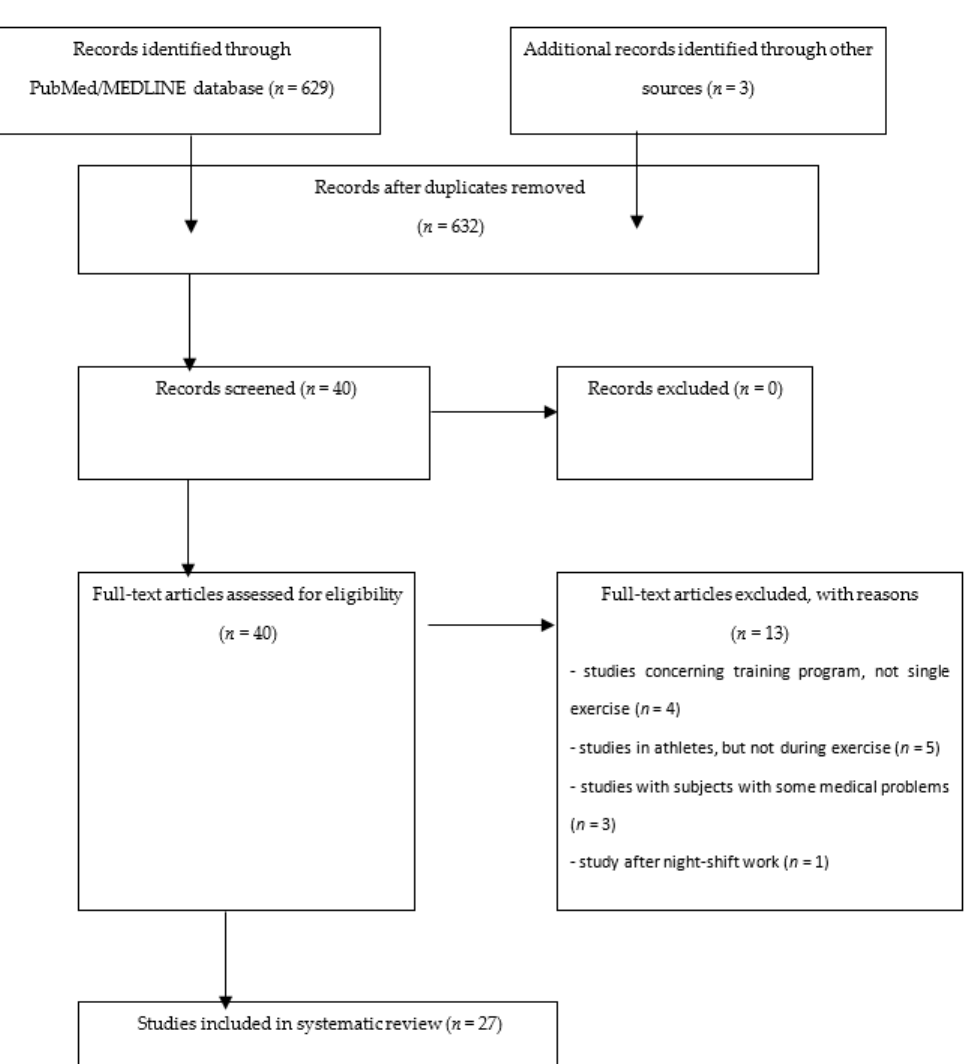
Figure 2. Flow chart illustrating the procedure for article inclusion and exclusion in a systematic review of changes in AKI biomarkers after exercise.